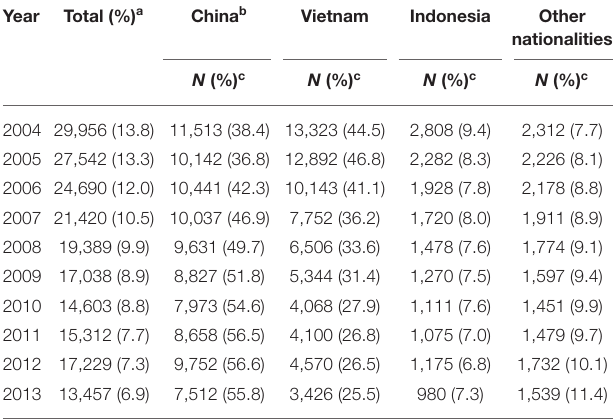
TABLE 1 | The number and proportion of newborns by nationality of immigrant